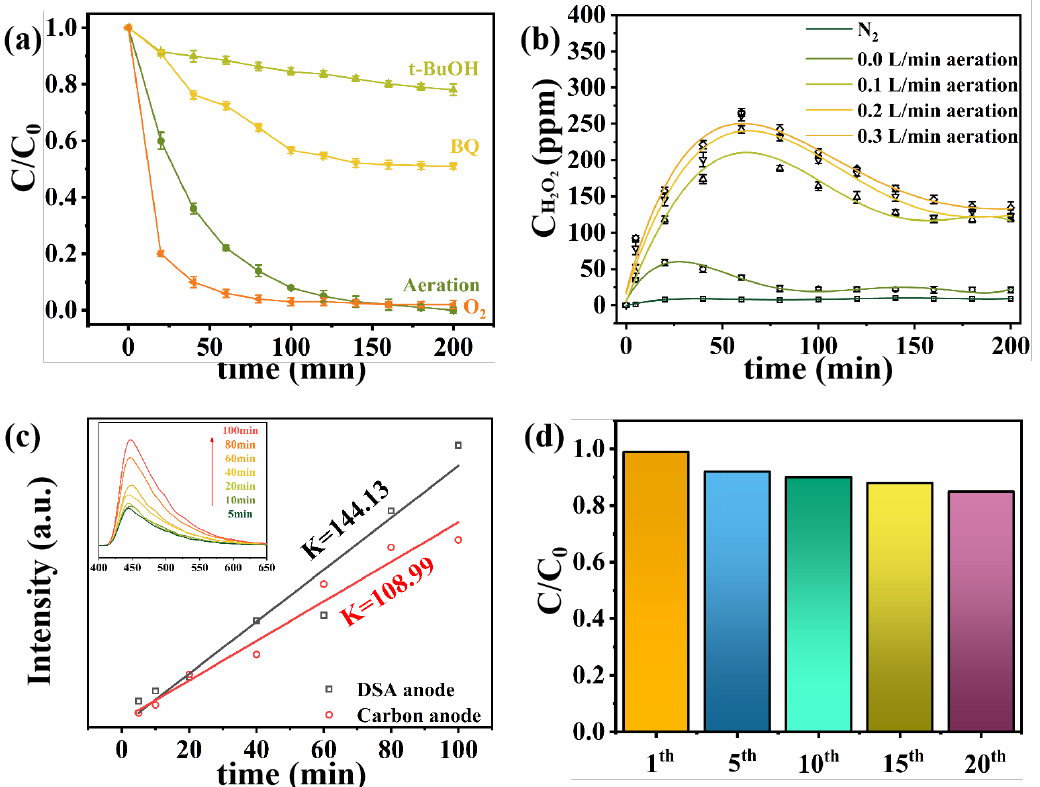
Figure 7. Free radical scavenging experiments ( a ). Hydrogen peroxide concentration detection experiments ( b ). Hydroxyl radical detection experiments ( e ). Stability test ( f ) by degradation of